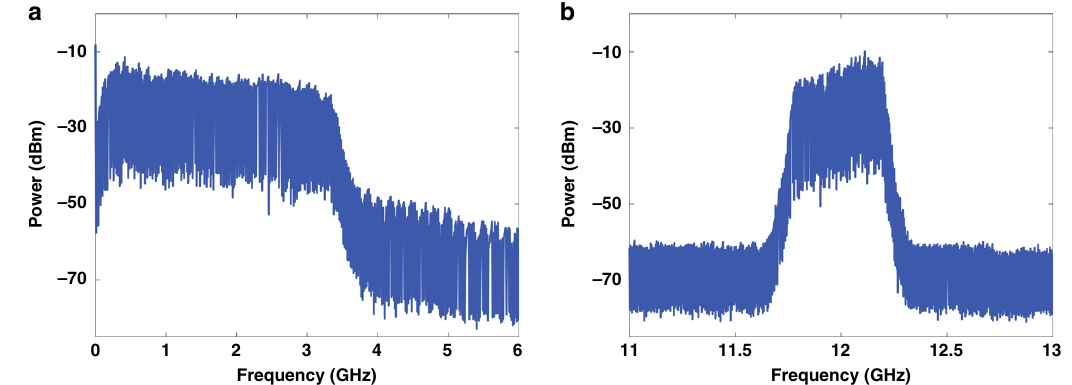
Fig. 3 Spectrum results with different radiofrequency fi lters in the link. a A low-pass radiofrequency fi lter with the cutoff frequency at 3.3 GHz (S & L bands) is placed in the cavity. b A bandpass radiofrequency fi lter centered at 12 GHz (X band) with a 3-dB bandwidth of 200 MHz is placed in the cavity.